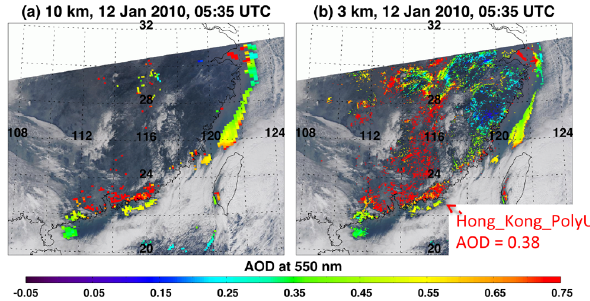
Fig. 5. Same as Fig. 3, but for 12 January 2010 during a pollution episode in China. Here the 3km algorithm is able to make retrievals over a much broader region. The AOD interpolated to 0.55µm from the only AERONET station in the image (Hong Kong PolyU) is 0.38. The 3km retrieval there is 0.45, while there is no 10km re- trieval available at that spot during this